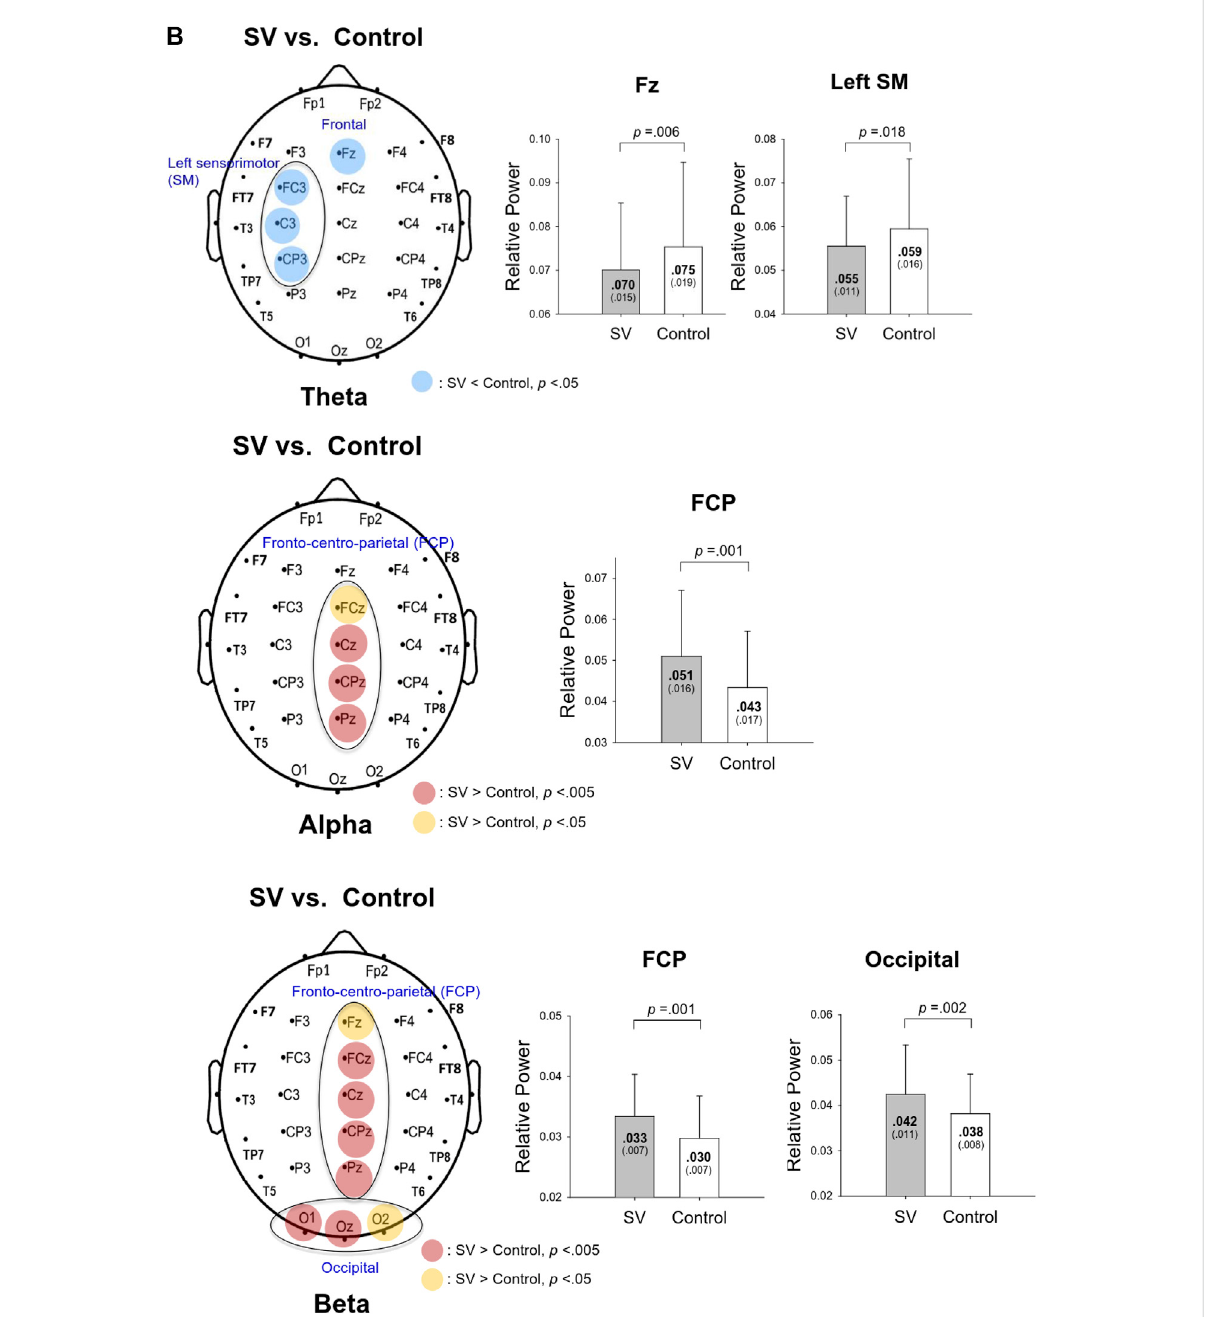
FIGURE 2B Schematic illustration of the SV-induced changes in the relative power of scalp electrodes for the theta (top), alpha (middle), and beta (bottom) bands. The right subplots of (B) contrast the mean relative powers at various spectral bands in the regions of interest between the SV and control conditions. A warm color indicates greater regional activity in the SV condition than in the control condition. A cold color indicates smaller regional activity in the SV condition than in the control